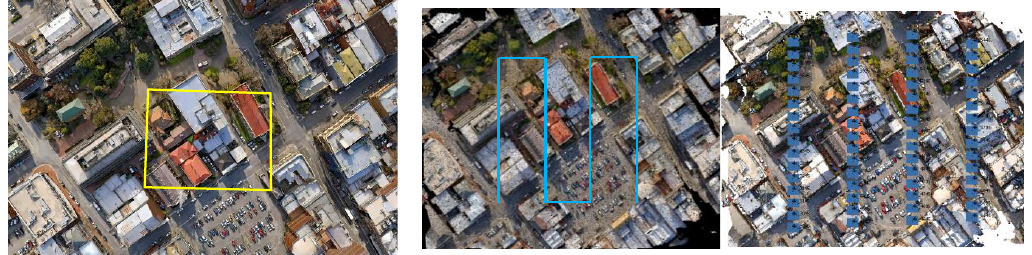
Figure 6. The Launceston 3D city model shows the area of interest inside the yellow boundary ( left ) and the grid flight trajectory ( right